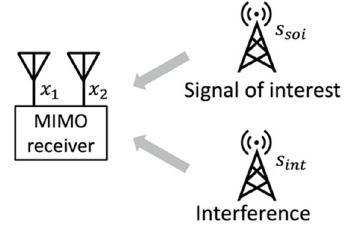
Figure 1. System model of BSS.